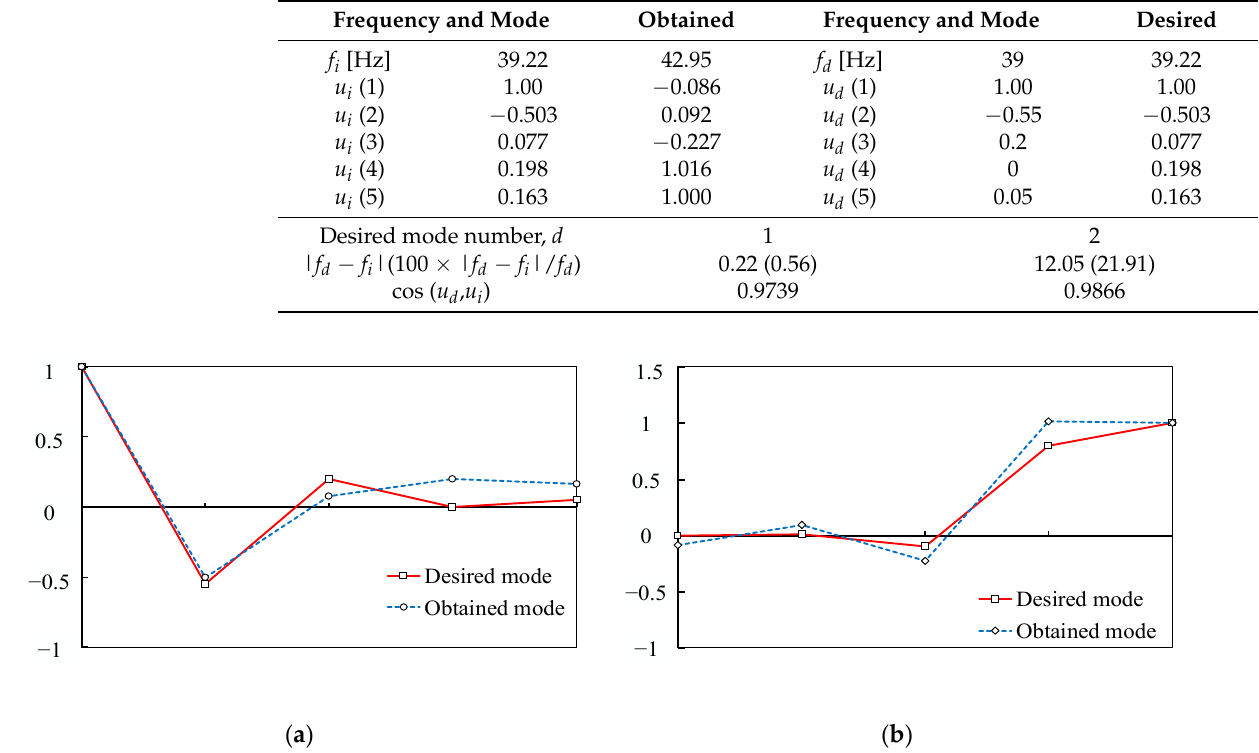
Figure 25. Comparison of desired and attained modes: ( a ) 39 Hz; ( b ) 55 Hz.